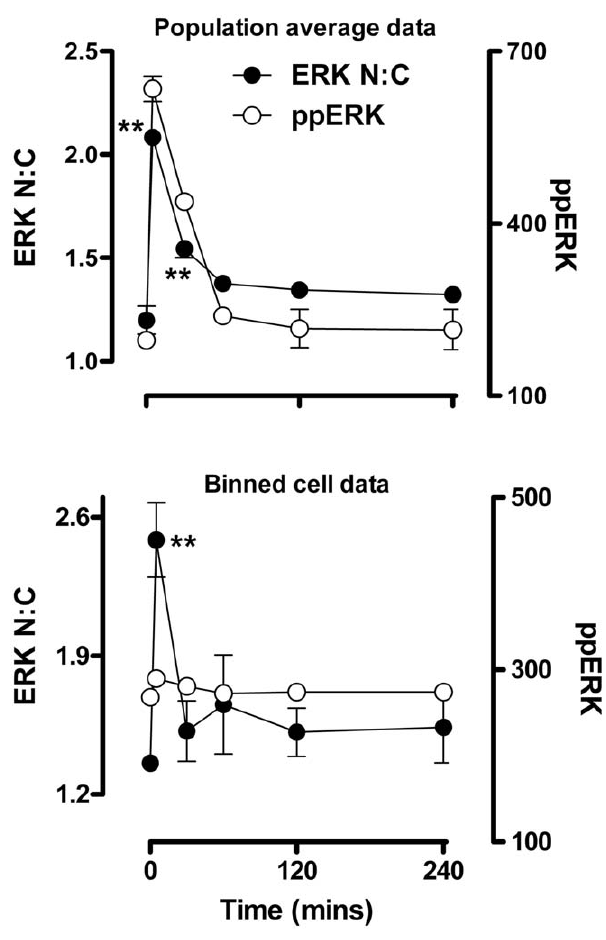
Figure 4. Time-dependent changes in GnRH-induced ERK localization occur at matched levels of TEY phosphorylation. Cells were treated, imaged and analysed as described for Fig. 2, except that the GnRH concentration was 100 nM. The top graph shows population average values for ppERK intensity in AFU (right y-axis) and ERK N:C ratio (left y-axis). The lower graph shows the same time-course, but comparing ERK N:C ratio (left y-axis) in cells within a comparable range (240–320 AFU) of ppERK staining intensity (right y-axis). Data are shown from 3 separate experiments (mean 6 SEM). One way ANOVAs and post-hoc Bonferroni tests revealed significant effects of GnRH on ERK N:C (**P , 0.01 compared to t=0) at 5 and 15 min for the population average data (upper panel) and at 5 min for the binned data (lower panel). doi:10.1371/journal.pone.0040077.g004 we calculated N:C ERK values for cells binned according to their ppERK values. This revealed the expected relationship in GnRH- stimulated cells, with N:C ppERK values showing a monotonic rise to a plateau of approximately 2.2 as ppERK values rise (from a bin centre of 40 to 860 AFU) (Fig. 6A, see also fig. 3B). This relationship was unaltered by AG1478 (Fig. 6A, right panel) but the plateau was markedly reduced (to approximately 1.7) in cells treated with GnRH in the presence of Ro31-8425 (Fig. 6A, middle panel). The MEK inhibitor PD0325901 greatly reduced ppERK levels so that bins could not be created for cells having high ppERK levels and the plateau could not be defined under these